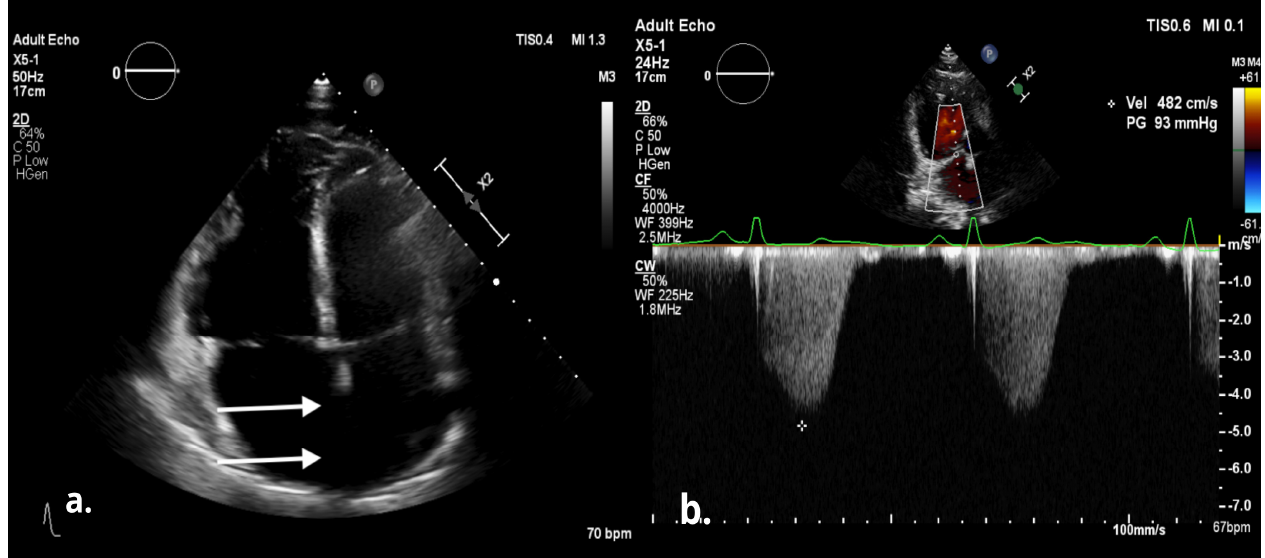
Figure 2. Transthoracic echocardiography imaging shows the dilatation of right heart chambers, atrial septal defect (marked by the arrows) ( a ) and tricuspid regurgitation with high maximal regurgitant velocity ( b ).